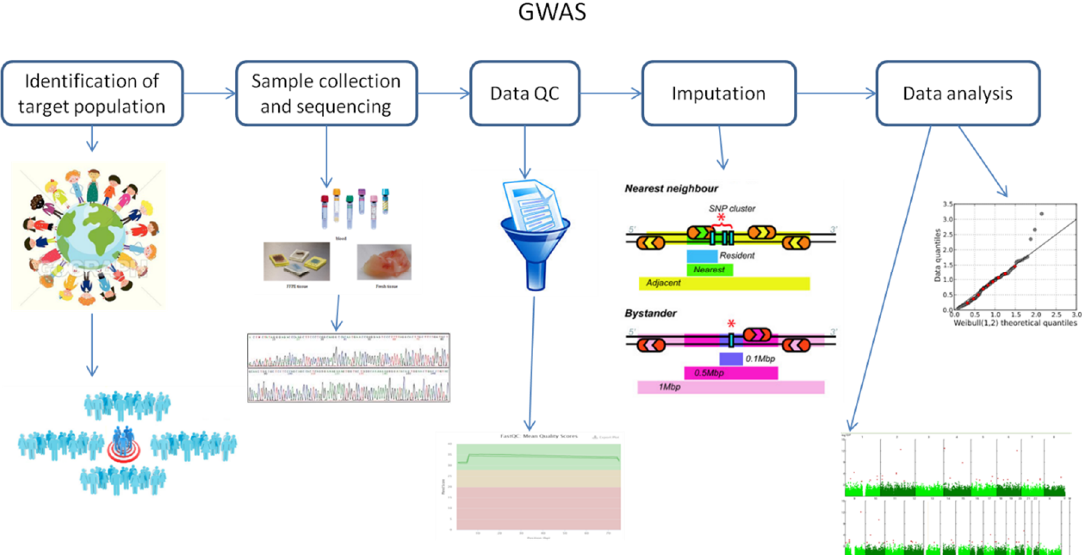
Figure 1. A technical flow chart for genome-wide association studies (GWAS). Abbreviation: QC, quality control.